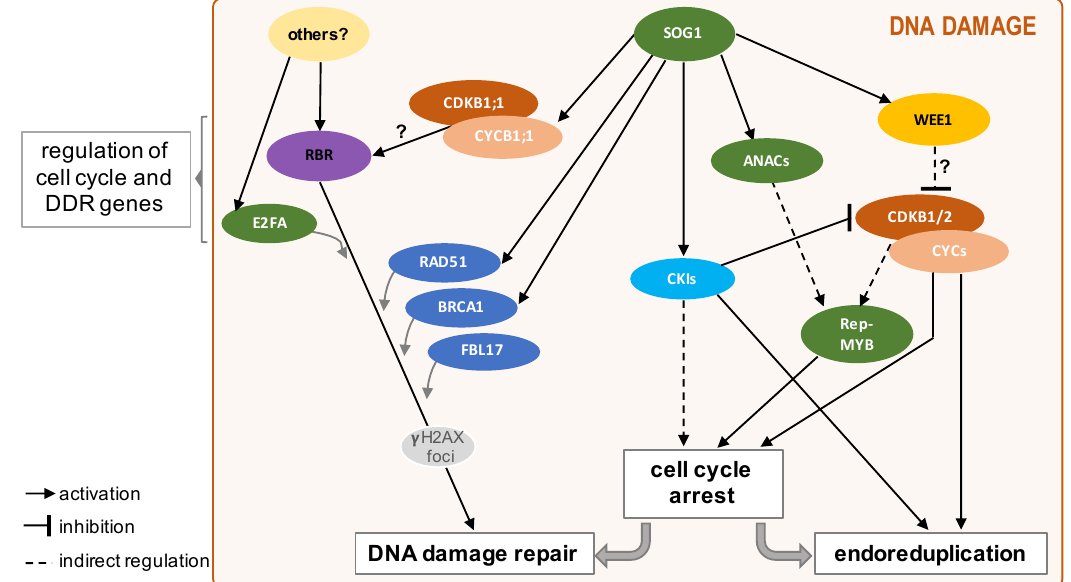
Figure 2. The SOG1-independent DDR signalling appears to favour the onset of DNA damage repair mechanisms. RBR, together with E2FA are key regulators of both cell cycle and DDR genes in the absence of DNA lesions [62]. Upon DNA damage, the SOG1 transcription factor overtakes the transcriptional regulation response to fine-tune DDR signalling. Thus, among hundreds of targets, the WEE1 kinase, other ANAC transcription factors or CKI proteins, such as SMR4 , SMR5 , SMR7, and KRP6, are activated. By inhibiting the CDK/CYC complex, other regulators, such as the Rep-MYBs, are not further phosphorylated, and these TFs accumulate in the cell, hence, contributing to block the cell cycle progression. Then, to avoid the transmission of damaged DNA, the cell will either switch towards endoreduplication or proceed to DNA lesion repair. In this option, the RBR-E2F pathway can be activated to setup DNA repair mainly by homologous recombination, this signalling pathway could be activated either via the activity of the CDKB1;1/CYCB1;1 complex, or via a SOG1-independent activation from upstream components not yet identified. Finally, if none of these alternatives is reached, then cell death will occur. A question mark (?) indicates that further experimental data are needed for confirmation of the indicated